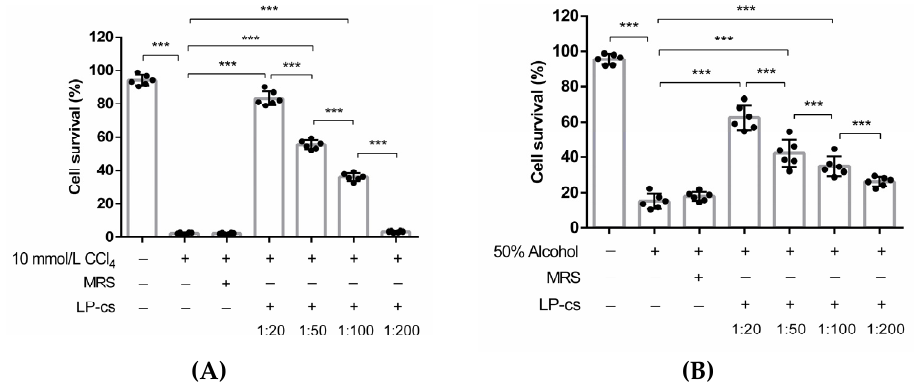
Figure 2. The survival rate of HL7702 cells in vitro : ( A ) The survival rates of HL7702 cells in the negative control group, 10 mmol/L CCl 4 -treated group, MRS-medium-pretreated group, and LP-cs-pretreated groups. The cell survival rates were 94.15 ± 1.32%, 2.48 ± 0.22%, 2.42 ± 0.15%, 83.25 ± 1.69%, 55.42 ± 1.13%, 36.04 ± 0.96%, and 3.35 ± 0.16%, respectively; ( B ) The survival rates of HL7702 cells in the negative control, 50% alcohol-treated group, MRS-medium-pretreated group, and LP-cs-pretreated groups. The cell survival rates were 95.62 ± 1.21%, 15.22 ± 1.77%, 18.05 ± 1.08%, 62.62 ± 2.84%, 42.23 ± 3.21%, 34.83 ± 2.25%, and 26.34 ± 1.07%, respectively. Data are presented as individual data points as well as the mean ± SEM for each group, with n = 6 per group. P -values were determined by one-way ANOVA. *** p < 0.001.